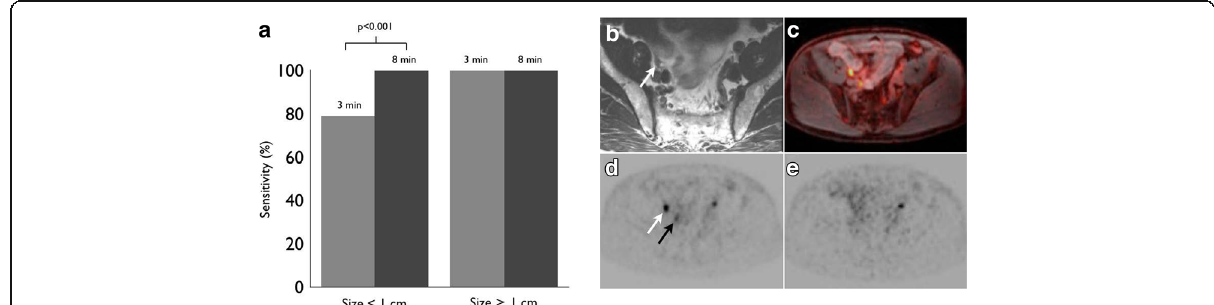
Fig. 5 Detection rate for abdominopelvic lymph nodes by size on 3- and 8-min PET acquisitions ( a ). The 8-min PET is more sensitive for lymph nodes smaller than 1 cm ( p < 0.001). The 3- and 8-min PET detected all lymph nodes larger than 1 cm. Example, 0.7-cm right external iliac lymph node visible on T2-weighted images ( b ), fused PET/MR images ( c ), and on 8-min PET acquisition ( d ), but not seen on 3-min PET acquisition ( e ). The right ureter is designated with a black